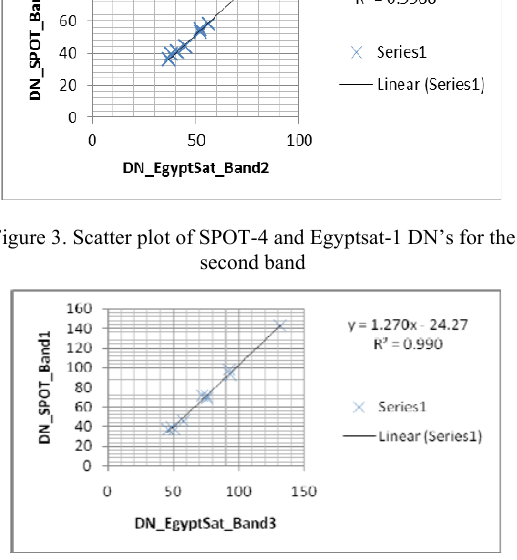
Figure 4. Scatter plot of SPOT-4 and Egyptsat-1 DN’s for the third band